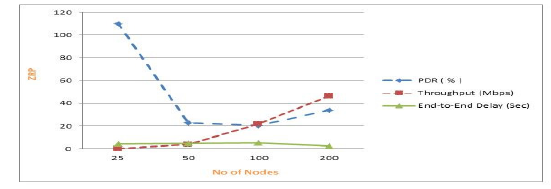
Fig. 7: ZRP with all performance